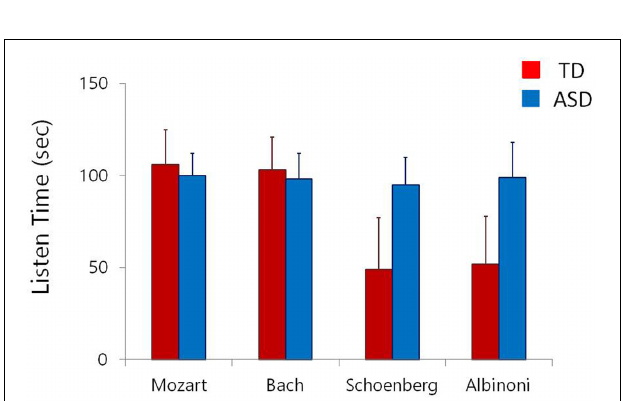
FIGURE 2 | Mean preference (error bars: SDs) for musical pieces of Mozart, Bach, Schoenberg and Albinoni in children with autism spectrum disorder (ASD) and in typically developing (TD)